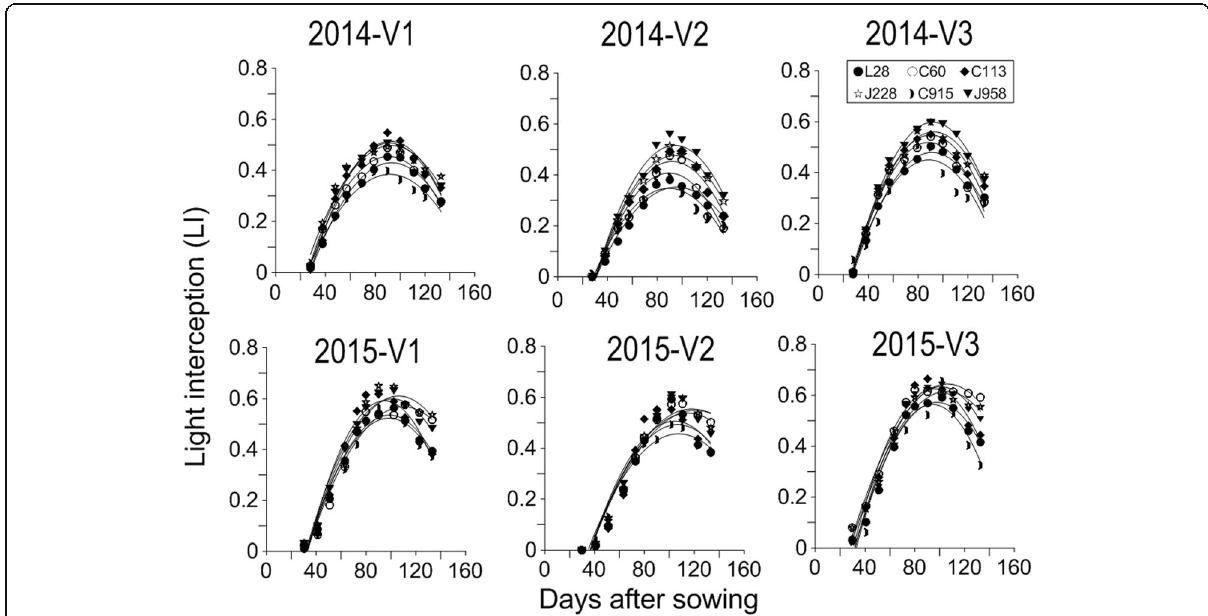
Fig. 4 LI horizontal distribution of six different cotton varieties with different plant types during the cotton growth period in 2014 and 2015